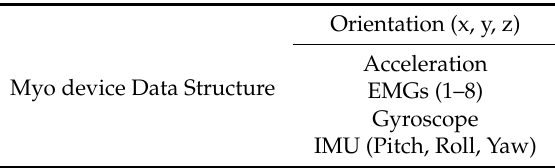
Table 1. Myo device dataset format